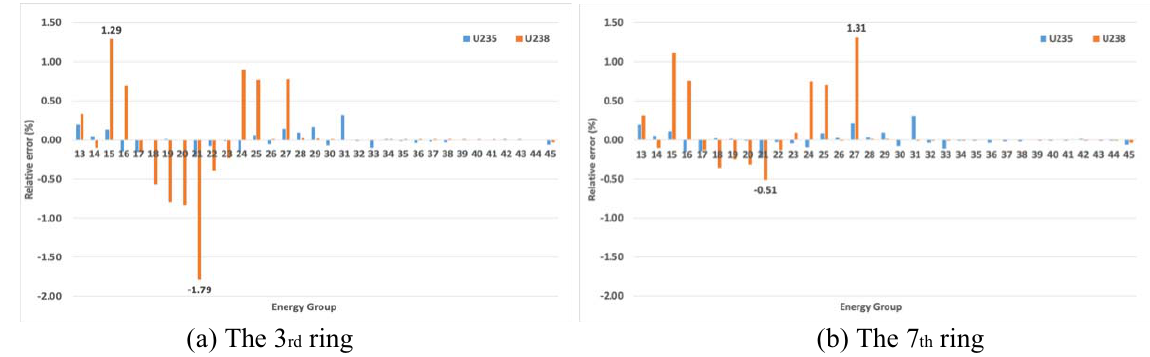
Figure 5. The absorption cross sections difference of the multi-fuel pin cell